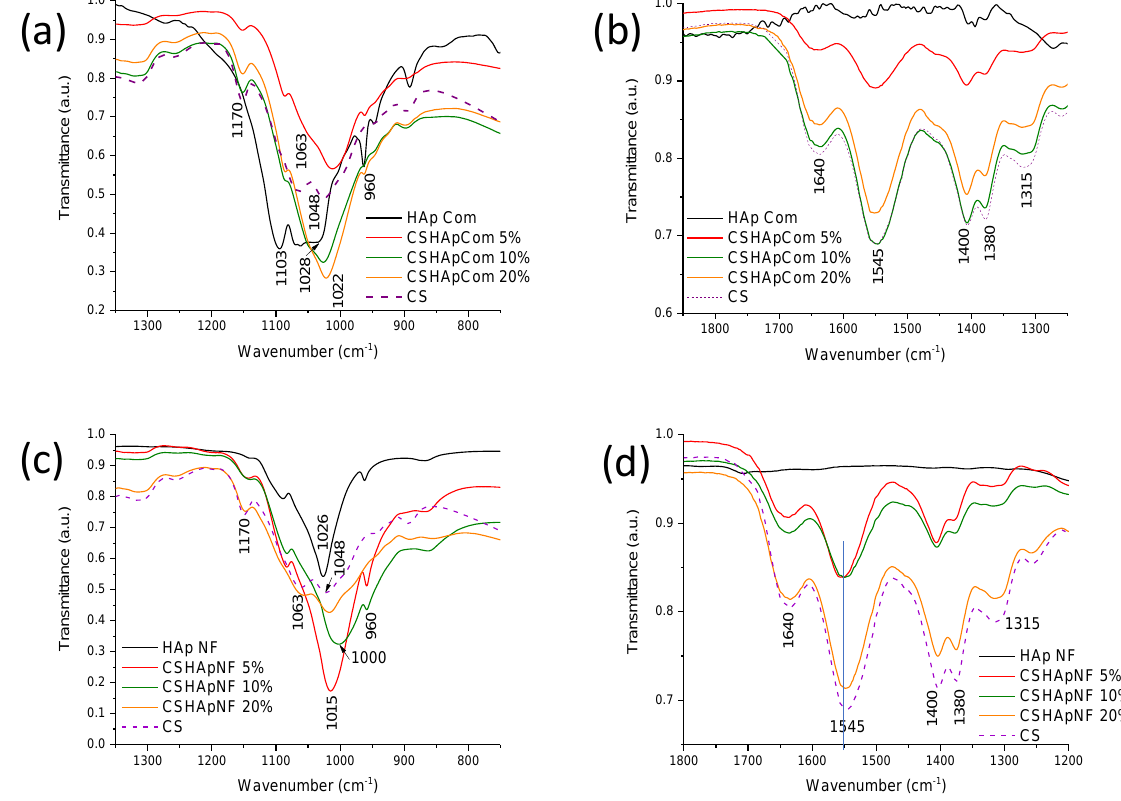
Figure 7. FTIR spectra of reference materials ( a , b ), and HAp nanofibers/chitosan composite materials ( c , d ).